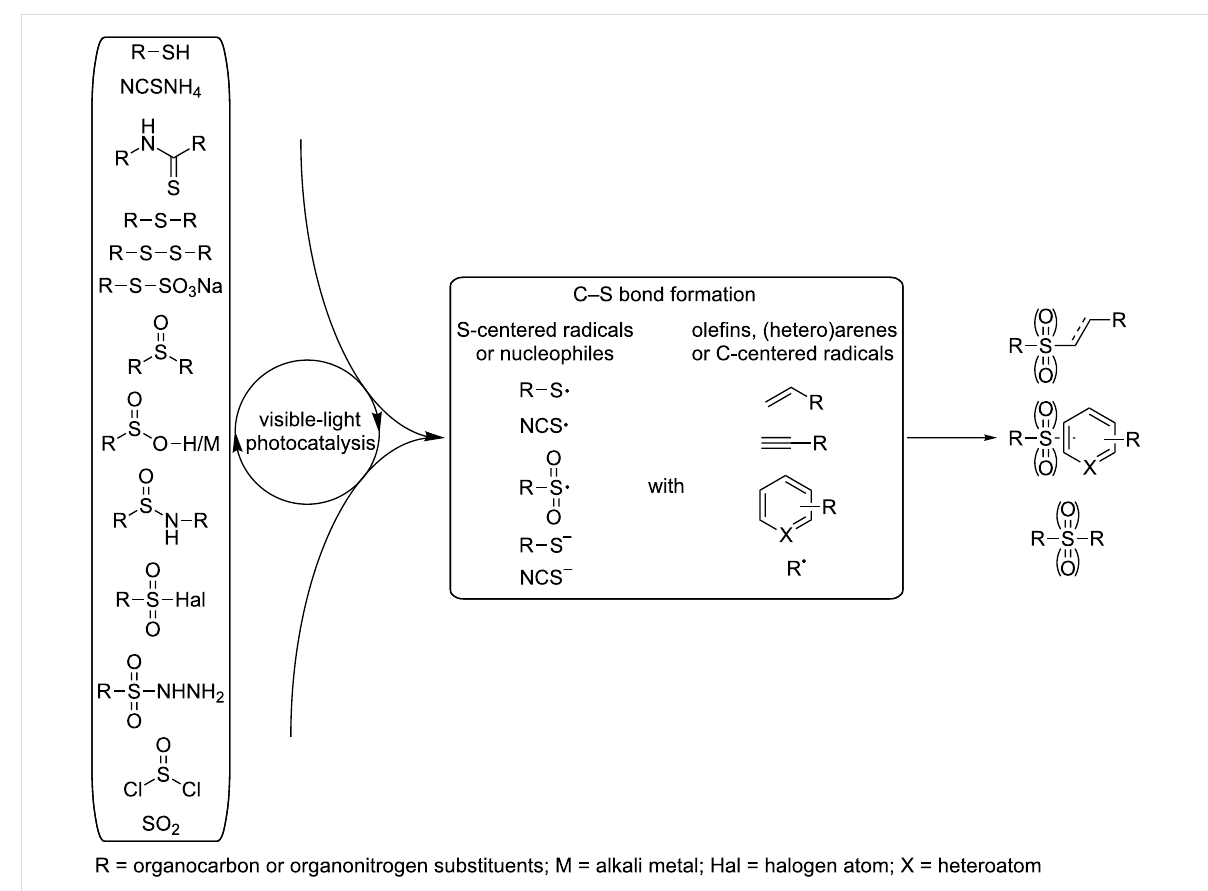
Scheme 1: General overview over the sulfur-based substrates and reactive intermediates that are discussed in this